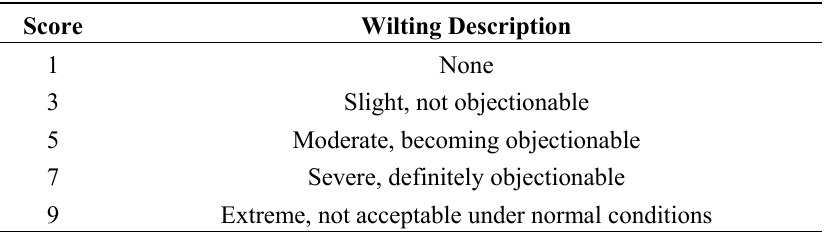
Table 4. Rating scale for the wilting of green